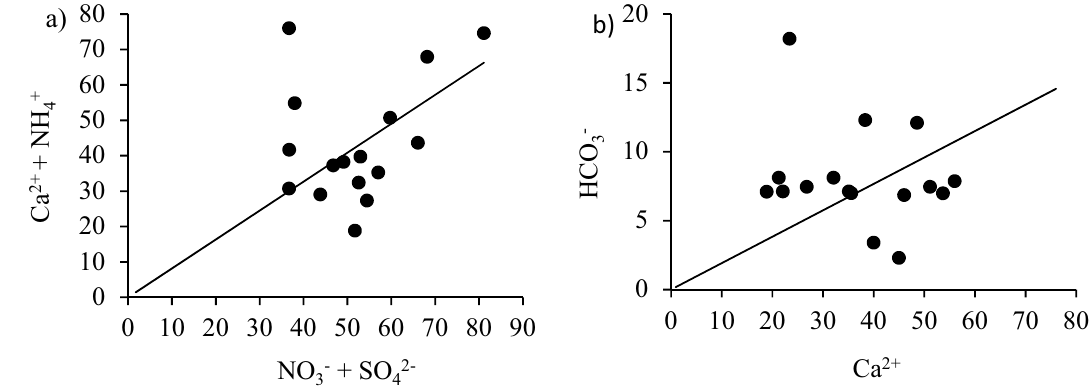
Figure 5. ( a ) Scatter plot of (Ca 2+ + NH 4+ ) against (NO 3− + SO 42− ) and ( b ) Ca 2+ against HCO 3− during the study period in Shaune Garang